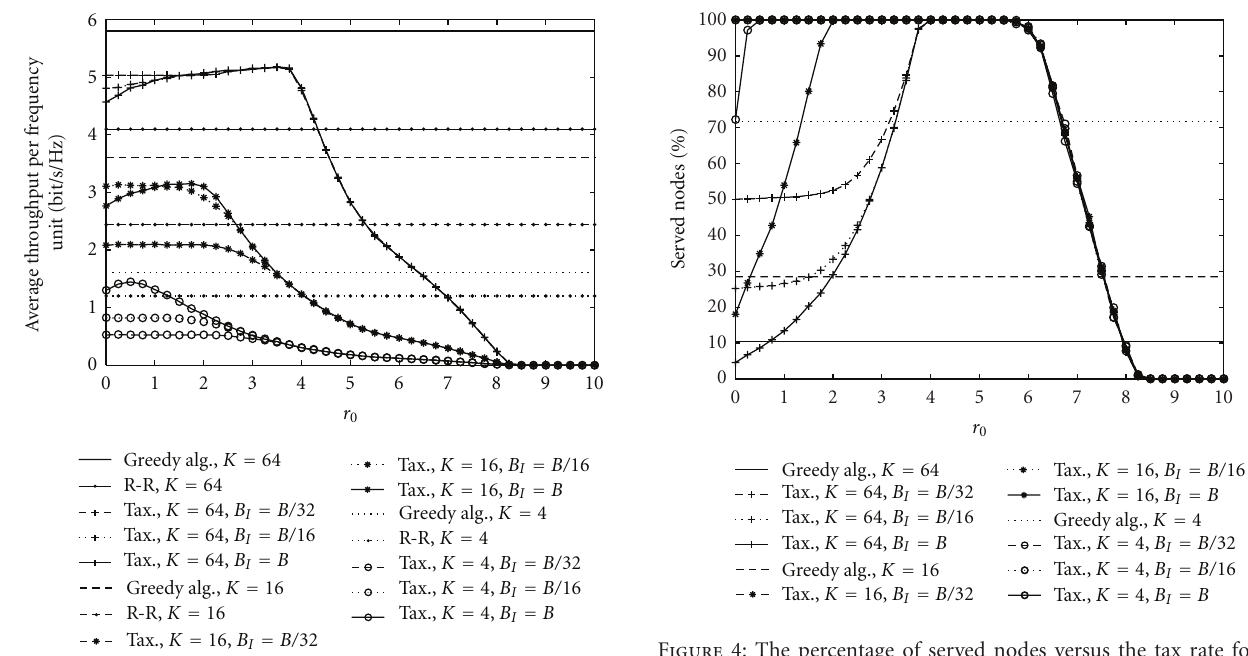
Figure 2: Average sum throughput η ST versus the tax rate for SelBM; two-path channel model.